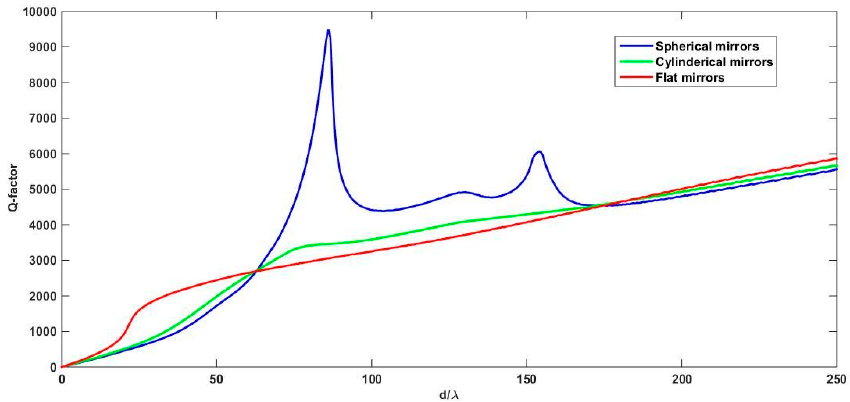
Figure 1. The theoretical values of the Q -factors for a FP cavity formed by straight mirrors, cylindrical mirrors, and spherical mirrors, plotted versus the diffraction length of the cavity.